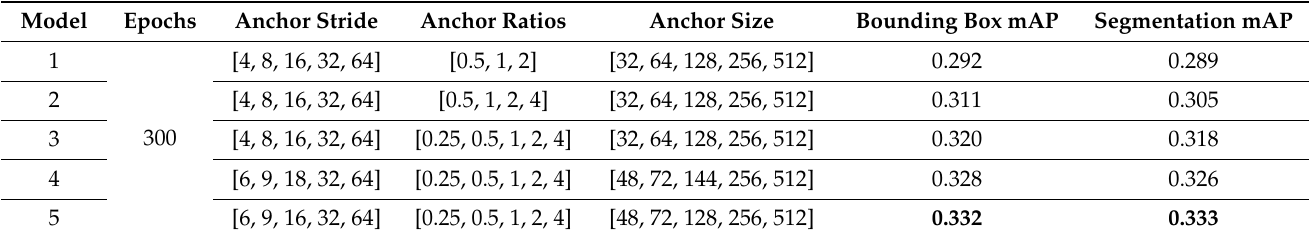
Table 4. Comparison of the results using different RPN parameters in the original Mask R-CNN